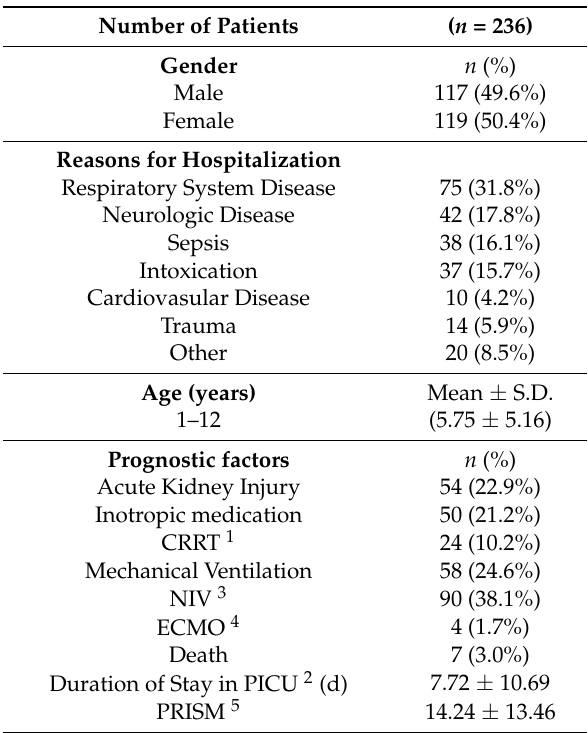
Table 1. Demographic characteristics of